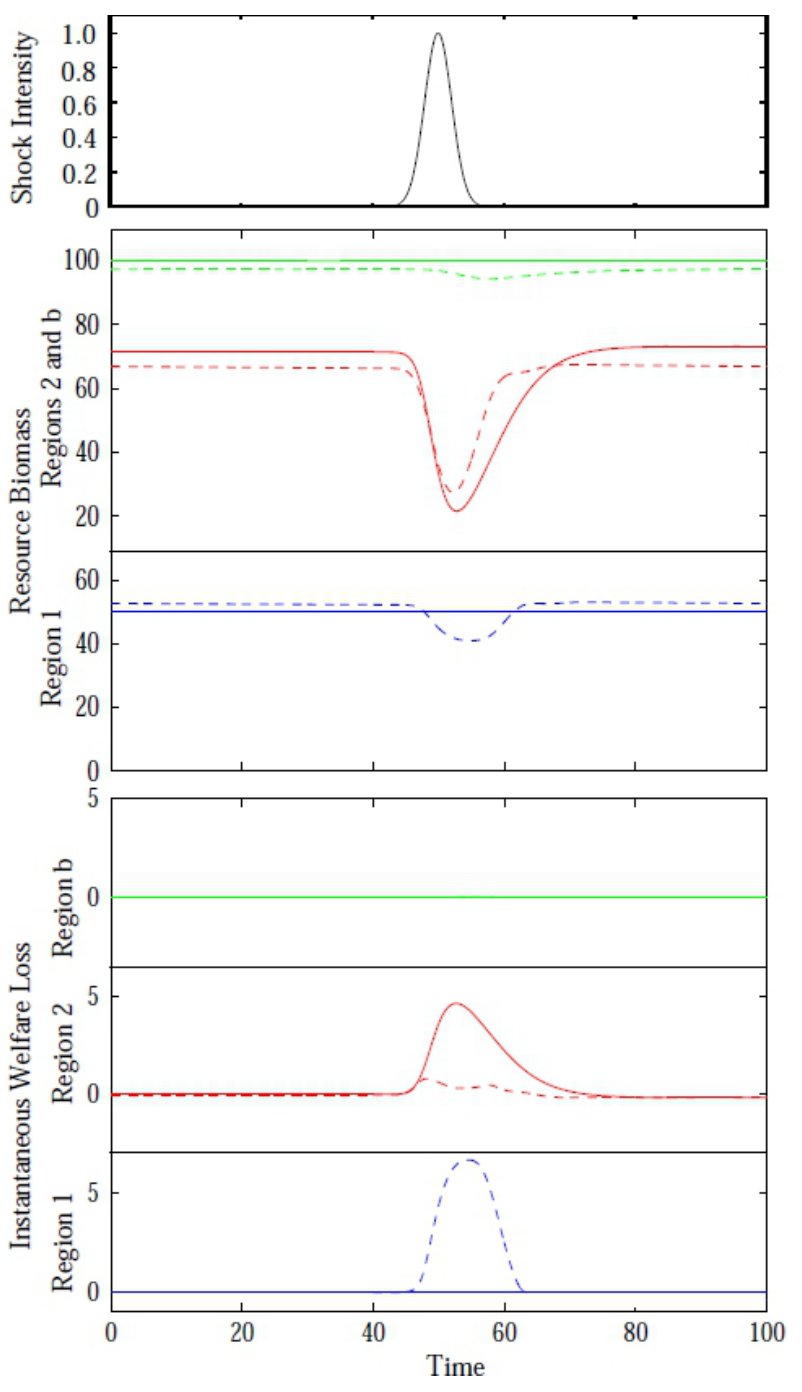
Fig. 6 . Resource density (center) and welfare loss (bottom) as a function of time after a high-frequency weather variation (top) that reduces resource densities in Region 2. Solid lines show the case without migration, dashed with migration. Colors correspond to those in Fig. 5. Note that there are multiple scales on the